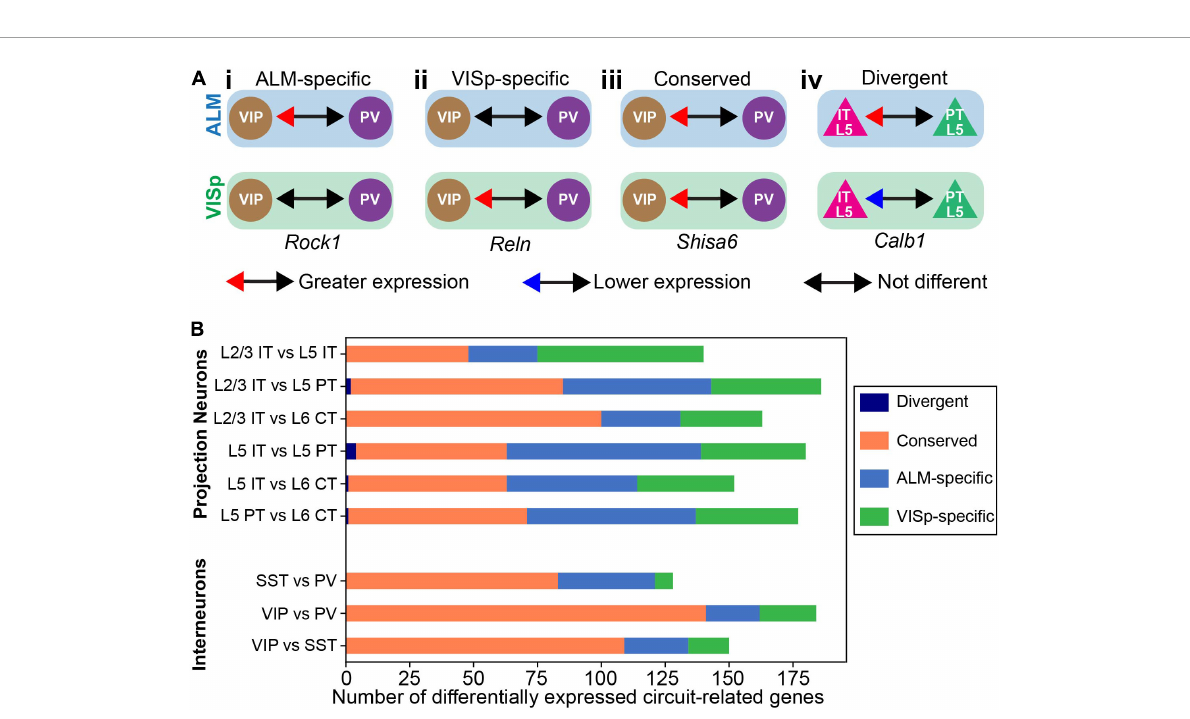
FIGURE4 Categorization of circuit-related genes that are differentially expressed between neuronal classes within ALM or VISp. (A) Examples of differential expression test results used to categorize circuit-related genes as: ALM-specific (Ai) , VISp-specific (Aii) , Conserved (Aiii) , or Divergent (Aiv) . The genes and results are real examples from the analysis. (B) Stacked bar plot of the total number of circuit-related genes in each category for every pairwise differential expression test between classes. “Divergent” genes were only observed in L2/3 IT vs L5 PT; L5 IT vs L5 PT; L5 IT vs L6 CT; and L5 PT vs L6 CT